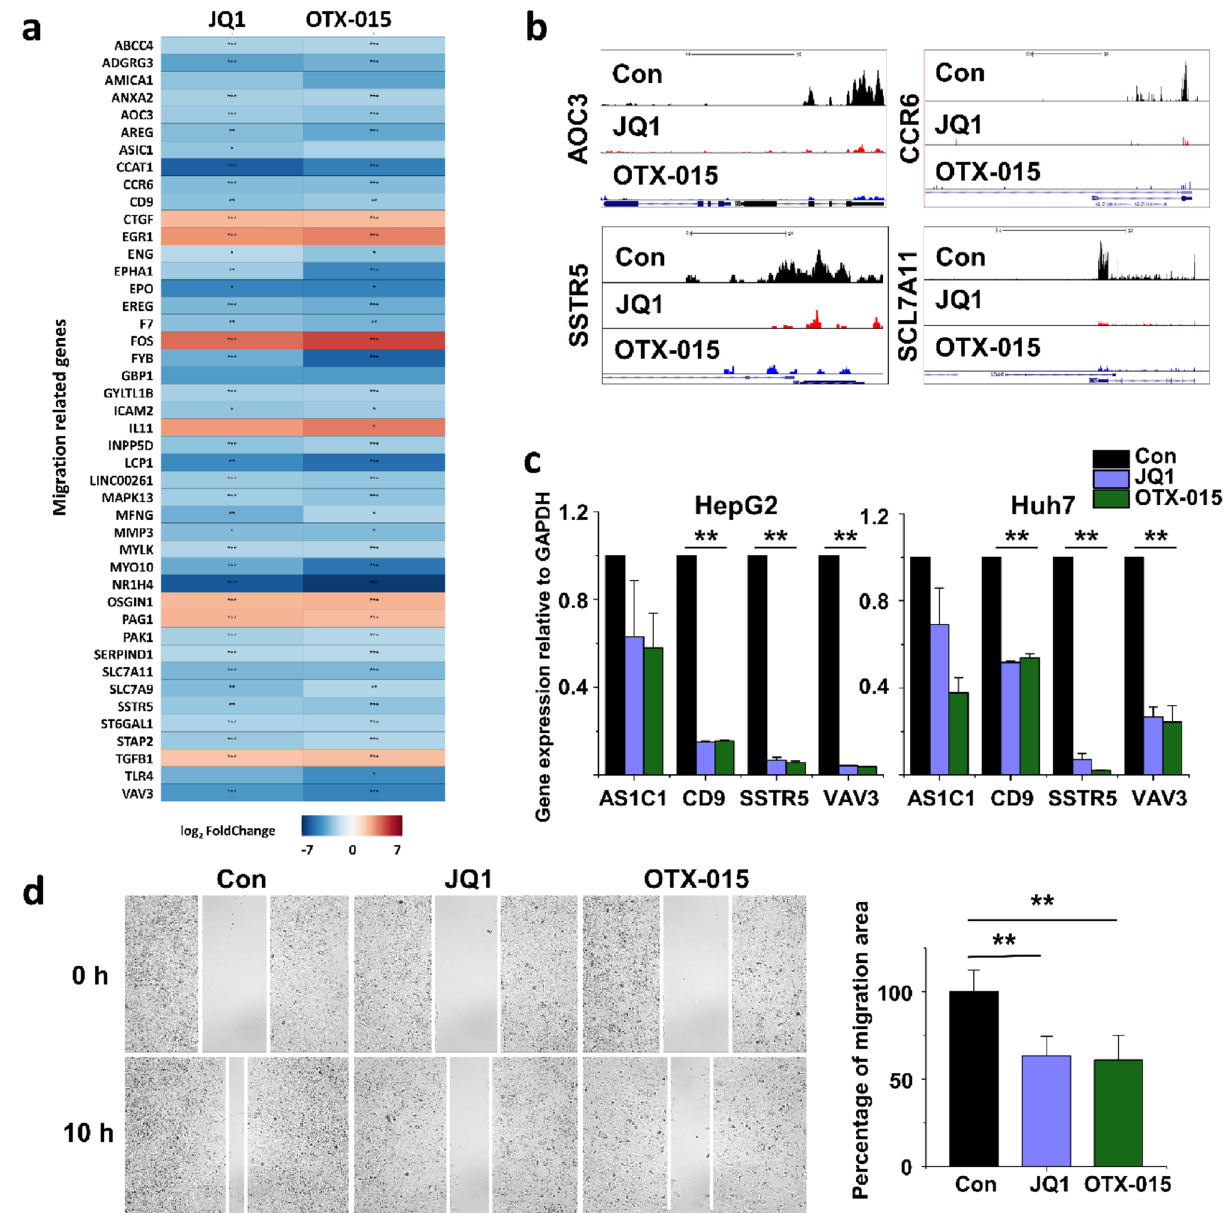
Figure 4. Downregulation of cell migration-related genes in BET inhibitor-treated HCC cells. ( a ) A heat map representing the migration-related genes in BET inhibitor-treated HepG2 cells compared with those in the controls. The color scale shown in the heat map represents the log2 fold change values. Red color indicates upregulated genes while blue color indicates downregulated genes. The heat map was created in R using the ggplot2 package version 3.3.3 (URL: https:// ggplo t2. tidyv erse. org) 69 . The p value with an asterisk attached in the cell represents * p < 0.05, ** p < 0.01, and *** p < 0.001. ( b ) The UCSC genome browser images show normalized RNA-seq read densities in control, JQ1-treated, and OTX-015-treated HCC cells. ( c ) Confirmation of differentially expressed genes using qPCR in JQ1- or OTX-015-treated HCC cells. The values are the mean ± S.D. from triplicate well measurements. ** p < 0.01. The data represent three independent experiments. ( d ) The migration of HCC cells was determined using a wound-healing assay. Migrating HCC cells were determined after 10 h of JQ1 or OTX-015 treatment. The area filled with HCC cells that entered the middle blank fields was calculated. The data represent three biologically, independent experiments. ** p <